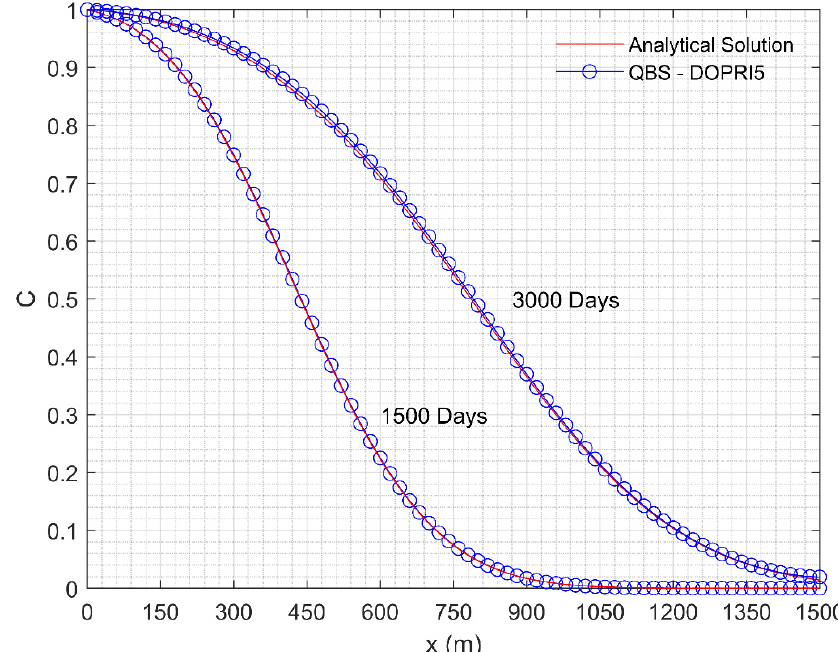
Figure 5. Comparison of approximate solutions with analytical solutions for different simulation times at centerline.